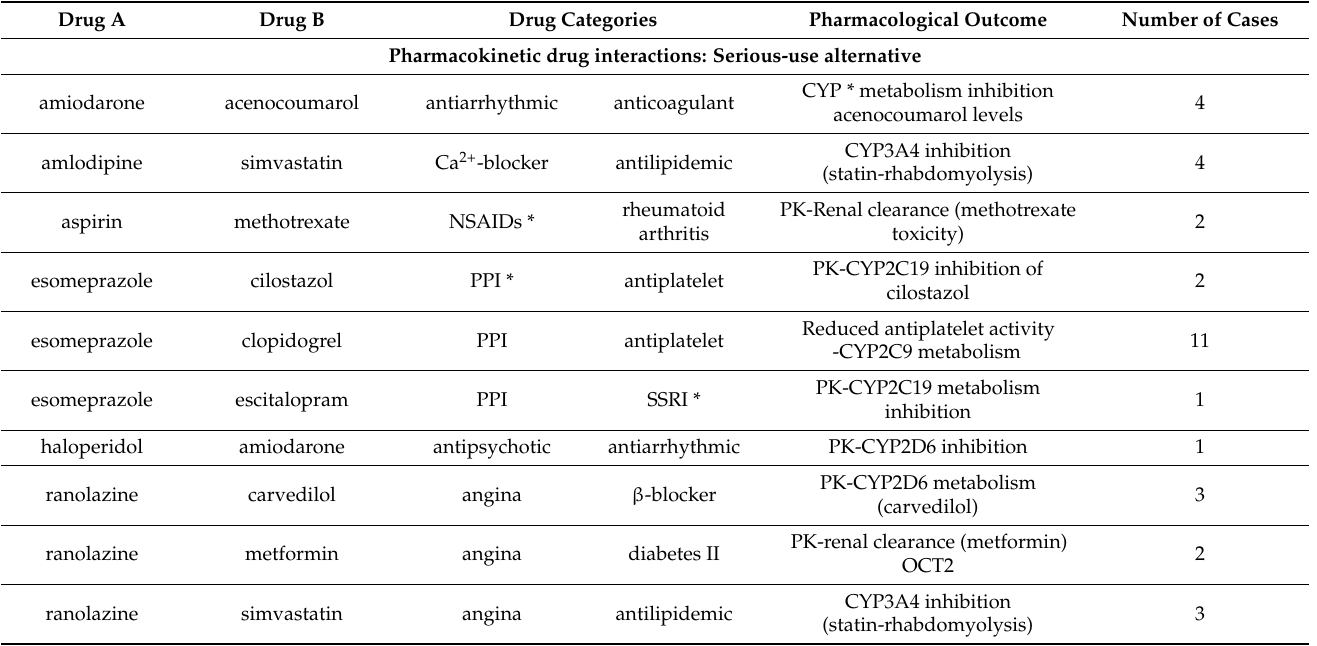
Figure 4. ( A ) Pharmacological mechanisms. ( B ) clinical significance of the identified drug–drug interactions (DDIs). ( C ) Time points of the DDIs. ( D ) DDI risk categories distributed over the four time points. ( E ) Clinical significance and pharmacological mechanisms involved. ( F ) Pharmacological mechanisms over time points for the DDIs. ( G ) Pharmacological mechanisms, time point, and clinical significance of the recorded DDIs (PK-DDIs: pharmacokinetic DDIs, PD-DDIs: phamacodynamic DDIs). Table 3. PK and PD-DDIs identified in the study (see supplementary file for full list and information). Drug A Drug B